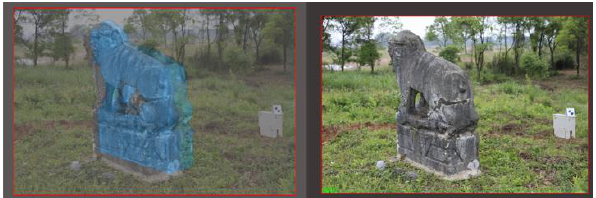
Figure 3. Overlap effect of 3d model with image. 2.2.2 Seed Area Extraction : For a given 3d model in the depth image, the background area has a same invalid value, while the front parts contain meaningful number. We make the depth image into a binary image to find model block. It is very easy to find the target area in depth image, leading to a result as shown in Figure 4.